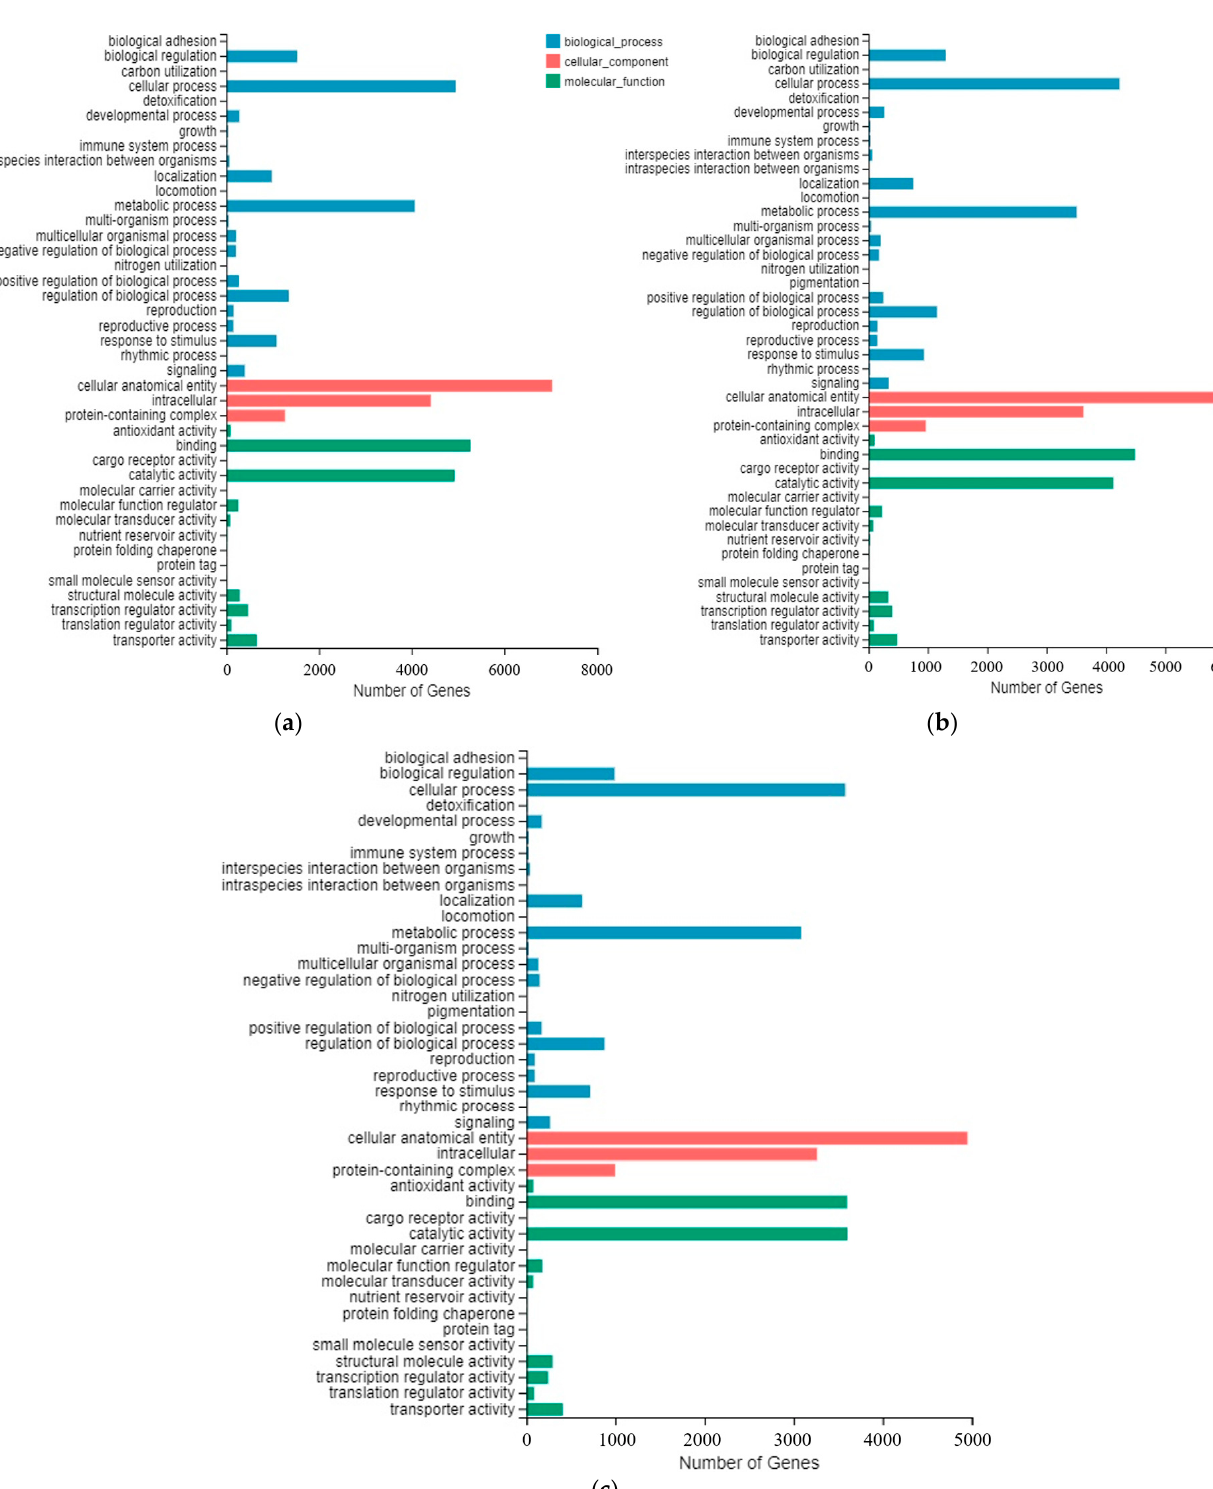
Figure 5 . Principal component analysis of different samples, hierarchical cluster, and distribution of DEGs. ( a ) principal component analysis of different samples; ( b ) Venn diagram of DEGs; ( c ), ( d ) and ( e ) represent the cluster heat map in S1 vs. S2, S1 vs. S3 and S2 vs. S3, respectively.